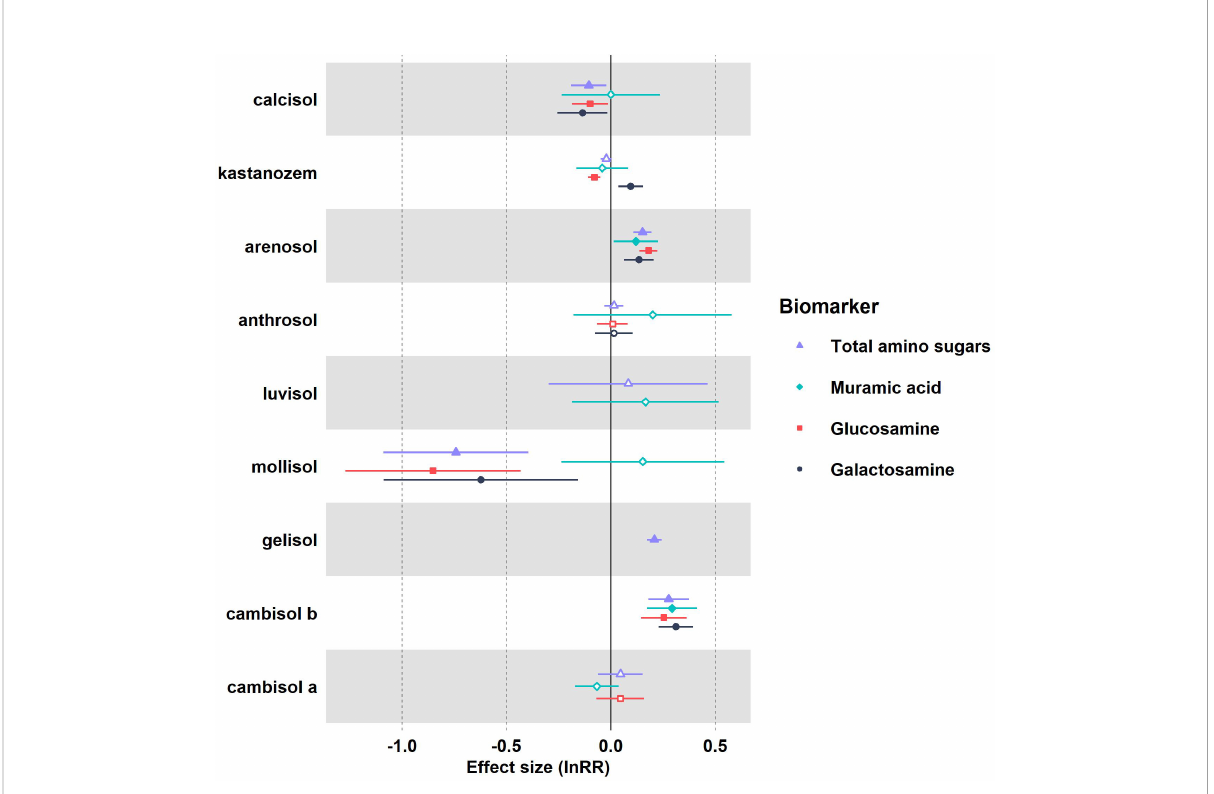
FIGURE 1 Forest plot of pooled natural log response ratios (lnRR) and 95% con fi dence intervals of total amino sugars (purple), muramic acid (light blue), glucosamine (red), and galactosamine (dark blue) in response to warming across soil groups. The vertical dashed line represents a lnRR of zero. Effect sizes are signi fi cant (p-value< 0.05) if the con fi dence intervals do not overlap with zero. Signi fi cant effect sizes are shown with fi lled in symbols whereas insigni fi cant effect sizes are hollow